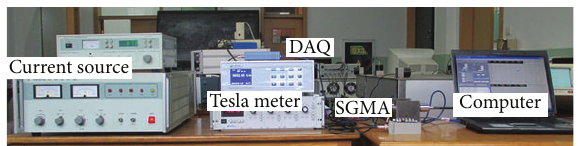
Figure 14: Setup for SGMA test system.